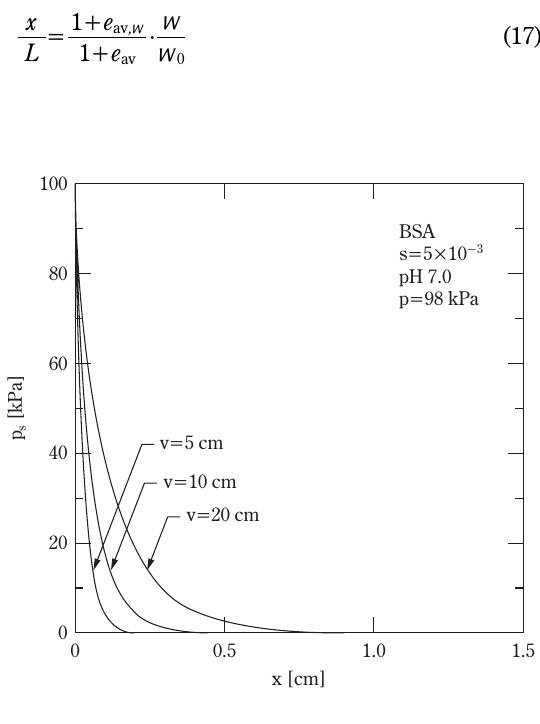
Fig. 6 Distributions of local solute compressive pressure in filter cake for different filtrate volumes.